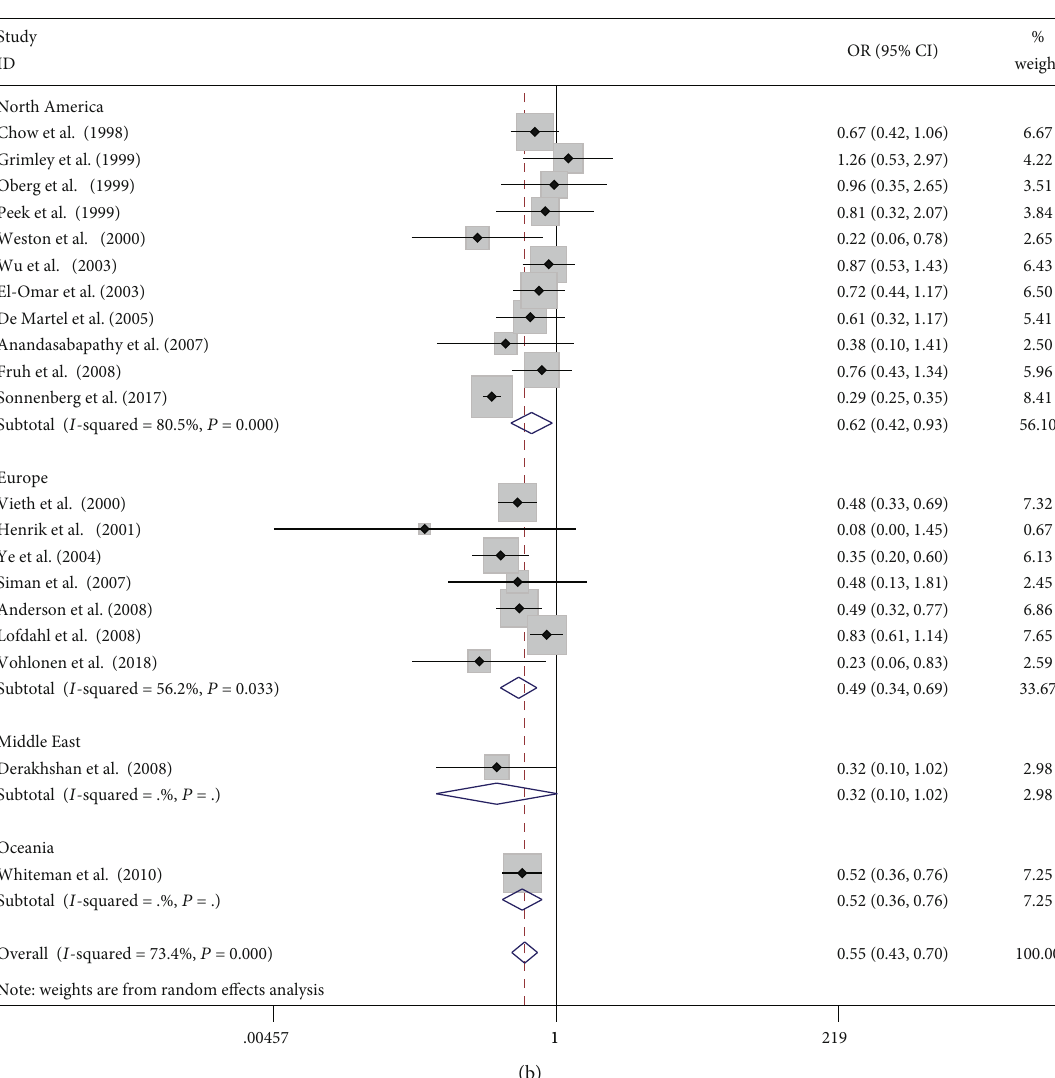
Figure 3: Meta-analysis of the association between Helicobacter pylori infection and esophageal cancer after grouping based on region: (a) forest plot of esophageal squamous cell carcinoma; (b) forest plot of esophageal adenocarcinoma. Each horizontal bar summarizes a study. Bars represent 95% CIs. Gray squares inform on each of the studies ’ weight in the meta-analysis. Diamond in the lower part of the graph depicts the pooled estimate along with 95% CIs.